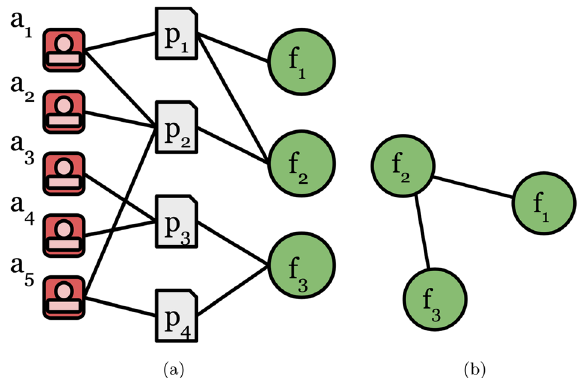
Fig. 1 The formation of a static Field of Study (FoS) network involving two steps: a creation of a heterogenous network of papers, authors and fields; b projection to an undirected network of fields, preserving field-paper-author-paper-field